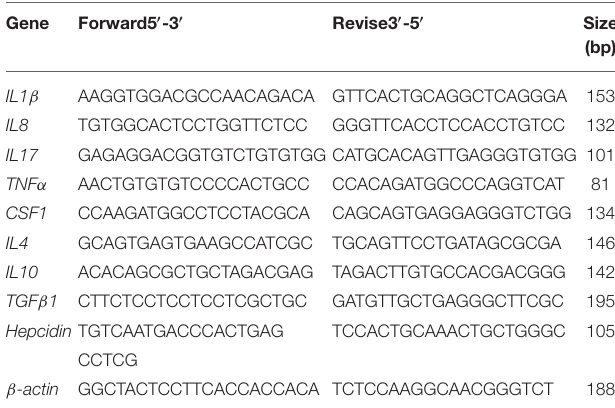
TABLE 2 | PCR primers for intestinal immune-related genes of pearl gentian